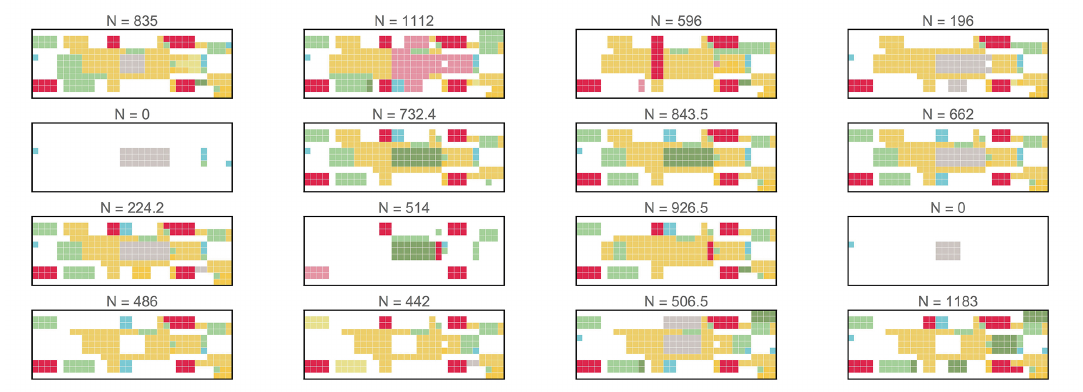
Figure 8. Configurations with corresponding numbers of visitors.